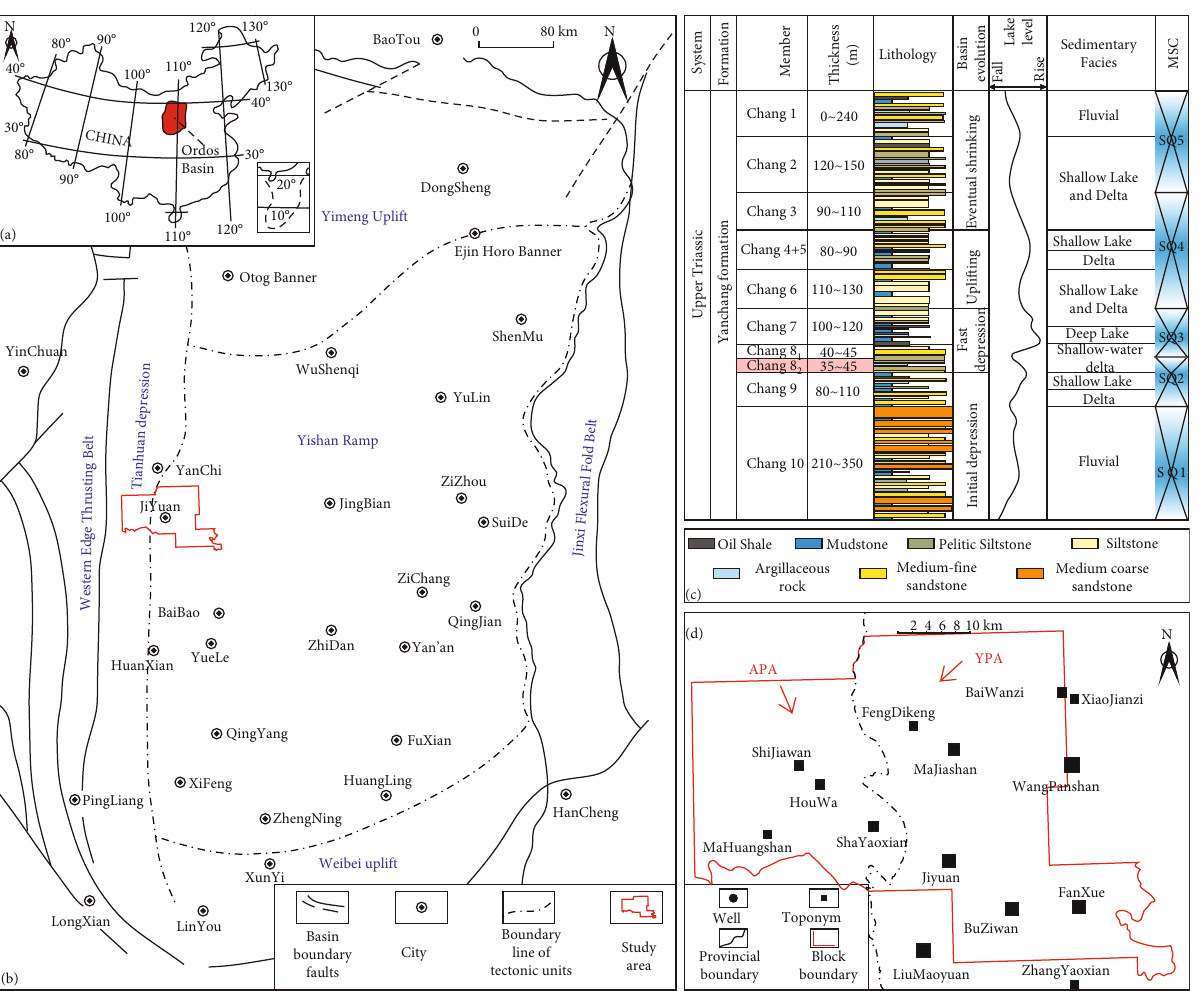
Figure 1: (a) Simpli fi ed map of China showing tectonic provinces and the location of the Ordos Basin; (b) map showing the tectonic subdivisions of the Ordos Basin and the location of the study area (modi fi ed after [31]); (c) stratigraphic table of the Ordos Basin showing Upper Triassic strata, the thickness of the 10 oil-bearing members of the Yanchang Formation and the associated lithology, basin evolution, sedimentary facies, and lake level fl uctuations (modi fi ed after [33]); (d) speci fi c location of the study area and the provenance direction that divides this area into the YPA and